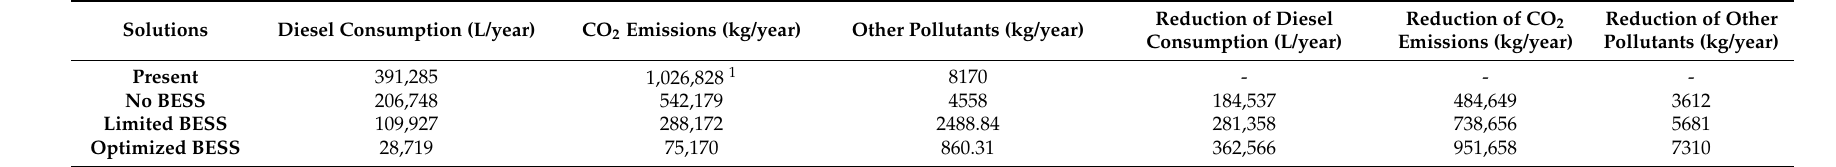
Table 3. Greenhouse gas emission comparison.